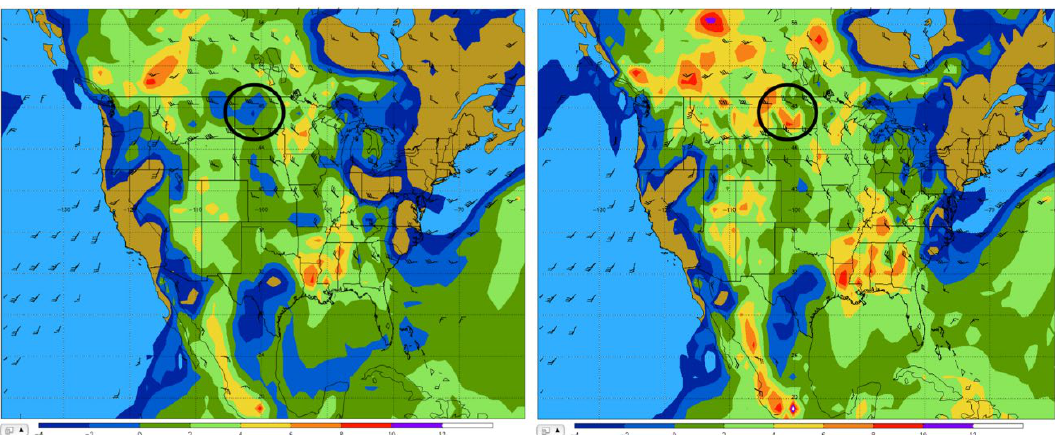
Figure 24. ( Left ): Lifted Index (-K) calculated using the parcel with the greatest moisture at either 925 or 850 hPa lifted to 500 hPa using the raw GEFS control member. Wind shear calculated over the layer where the parcel originated to 500 hPa and displayed if over 15 knots. Model cycle 0000 UTC 30 July 2010 with forecast valid 0000 UTC 01 August 2010. Circled area is where the model produced convection, reducing instability. ( Right ): Same as left but using the bias corrected GEFS control member instead of the raw.